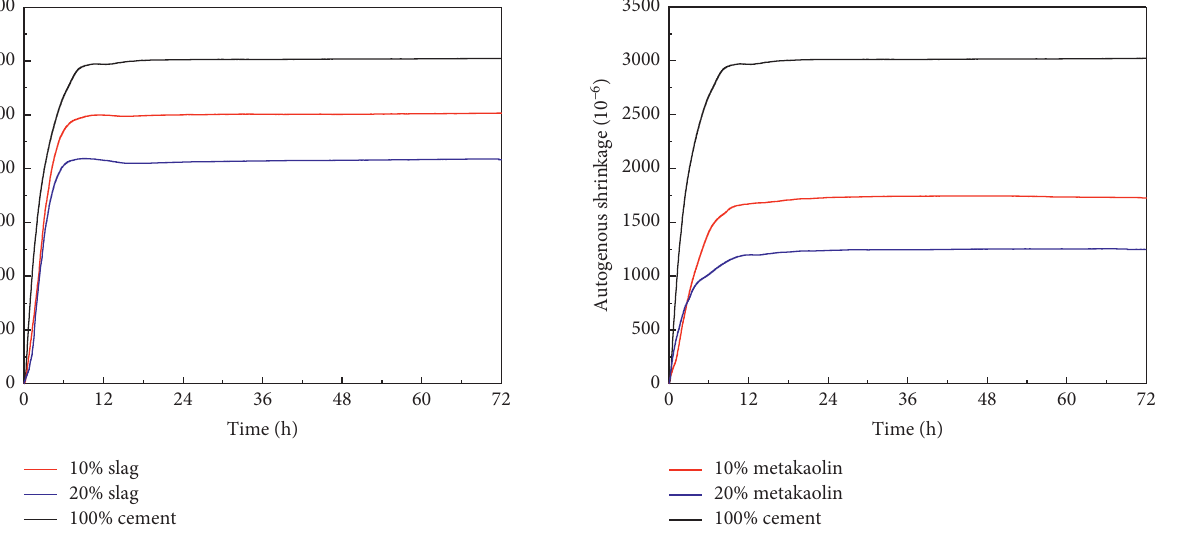
Figure 16: Effect of PCE-2 and metakaolin dosage on autogenous shrinkage of cement mortar.